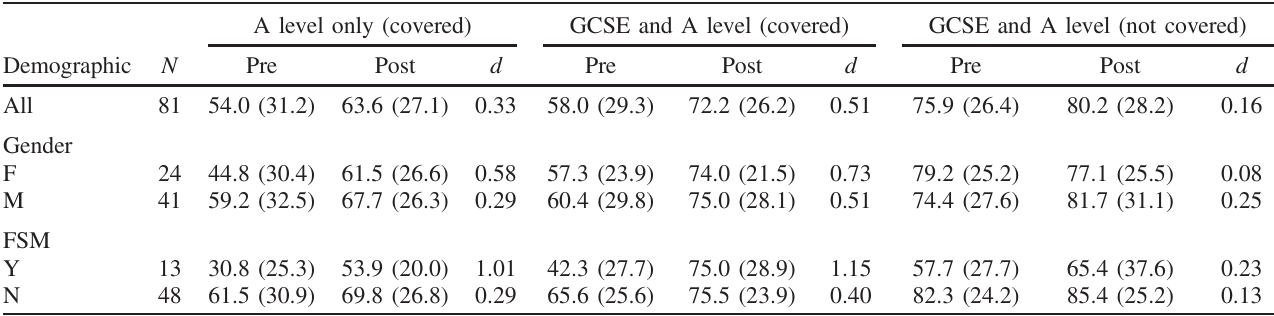
TABLE V. Physics pre- and post-test scores for each of the demographics and by level. Marks are shown as a percentage for that level group. We display the mean, the standard deviation of the sample in brackets, and the Cohen ’ s d between pre- and post-test scores. N indicates the number of students in each sample. A level only (covered) GCSE and A level (covered) GCSE and A level (not